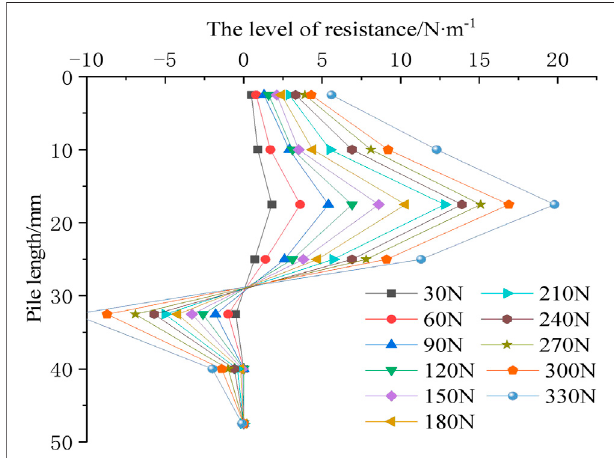
FIGURE 11 | Horizontal resistance curve under horizontal static load.